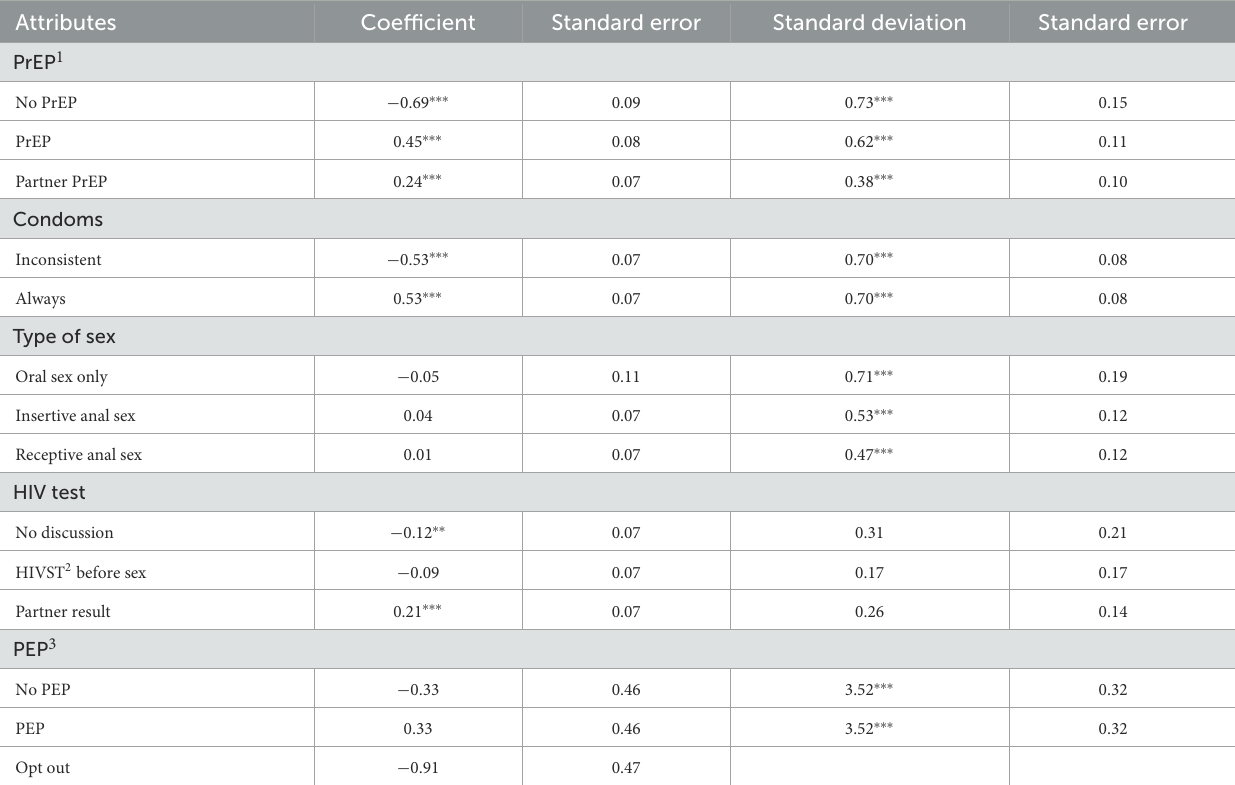
TABLE 3 Preferences for HIV prevention strategies among overseas born MSM ( N = 286), random parameters logit